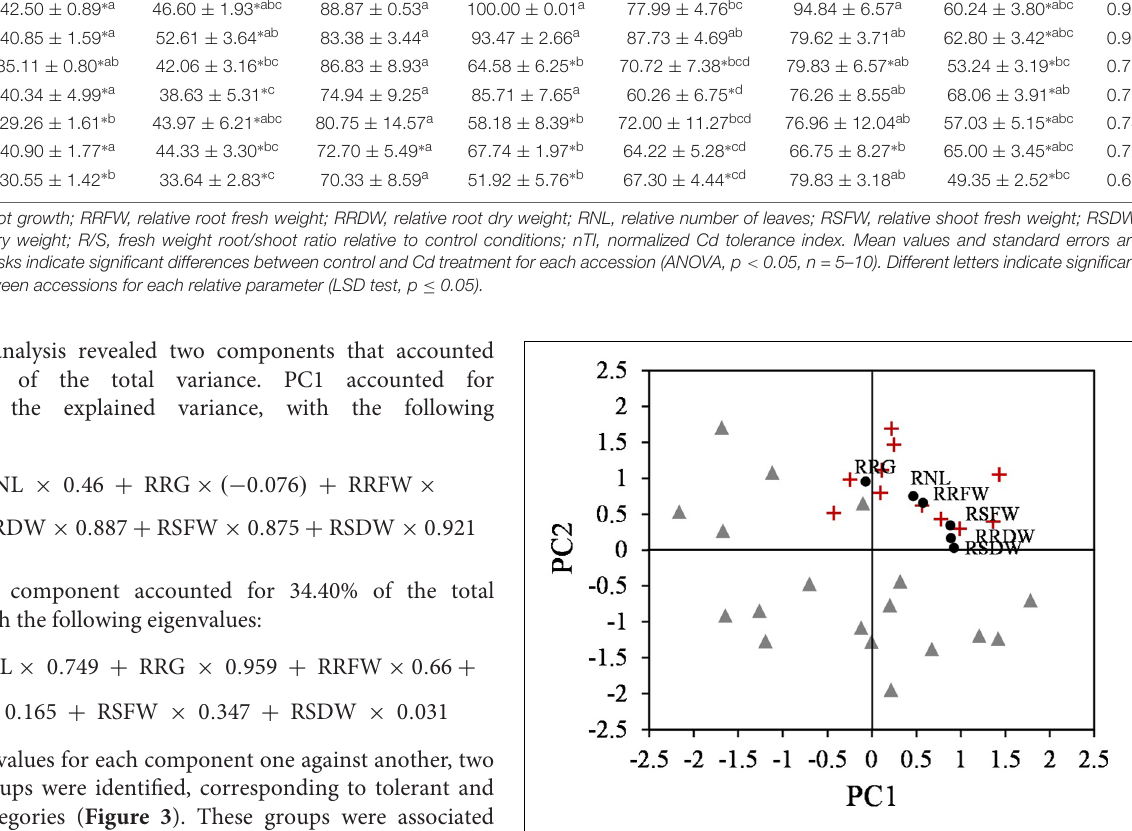
FIGURE 3 | Scatter plot of the two components obtained from PCA that differentiate two groups, tolerant (+) and sensitive ( (cid:49) ) accessions ( n = 25), and the relative parameters according to the eigenvalues ( •